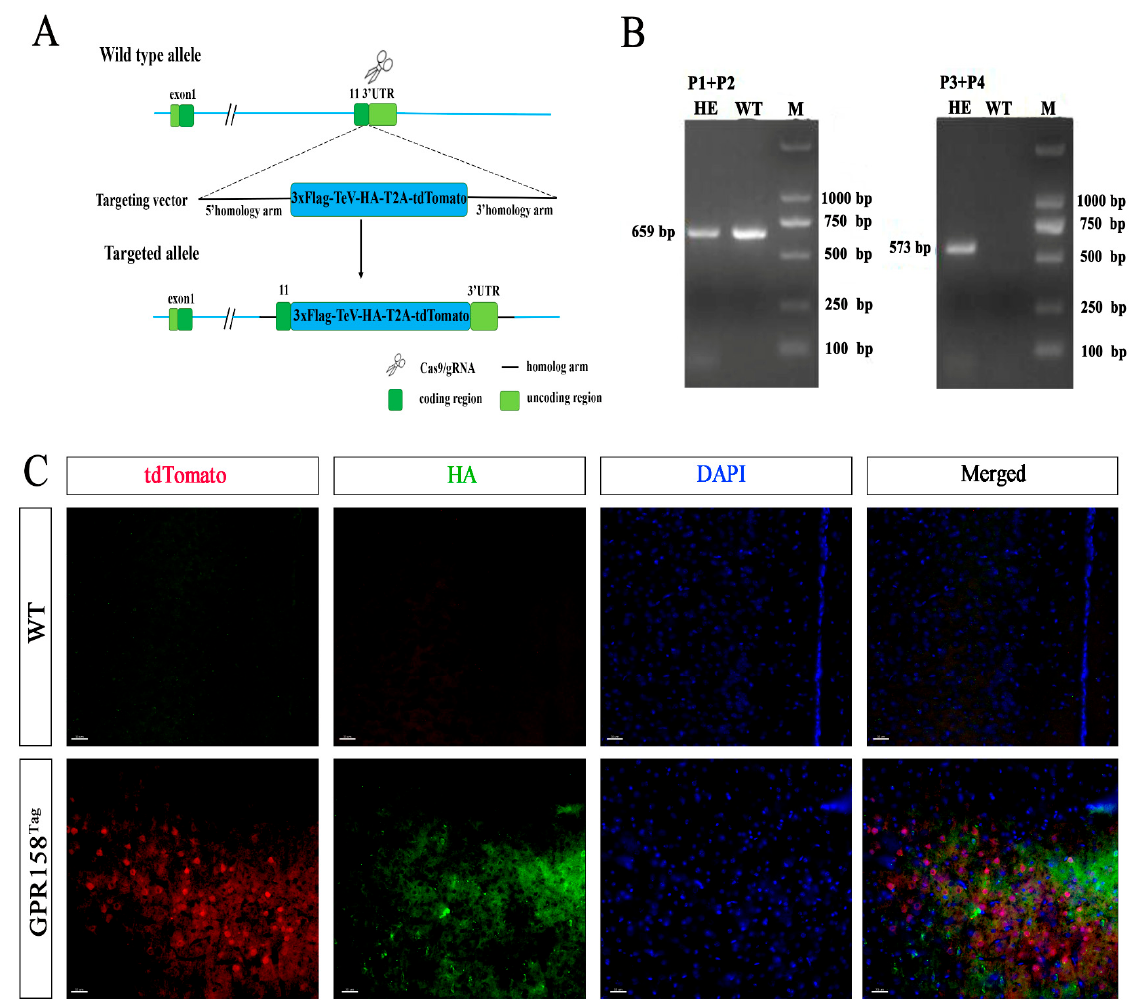
Figure 1. Generation of GPR158 Tag mice. ( A ) Schematic diagram of the GPR158 Tag mouse construc- tion strategy. The 3×Flag-TeV-HA-T2A-tdTomato expression frame was targeted via homologous recombination at the Gpr158 gene stop codon site using CRISPR/Cas9 technology. Stably expressed Gpr158 knock-in 3×Flag-TeV-HA-T2A-tdTomato heterozygous mice were generated. ( B ) PCR gen- otyping analysis. Representative result of the PCR screening of GPR158 Tag mice showing 659 bp band (wild-type allele) and 573 bp band (mutant allele). ( C ) Immunofluorescence images of tdTomato and HA-labeled GPR158 + cells and GPR158 molecules, respectively, in the cerebral cortex of GPR158 Tag mice compared with Wild-type (WT) mice. Scale bars, 30 μ m.